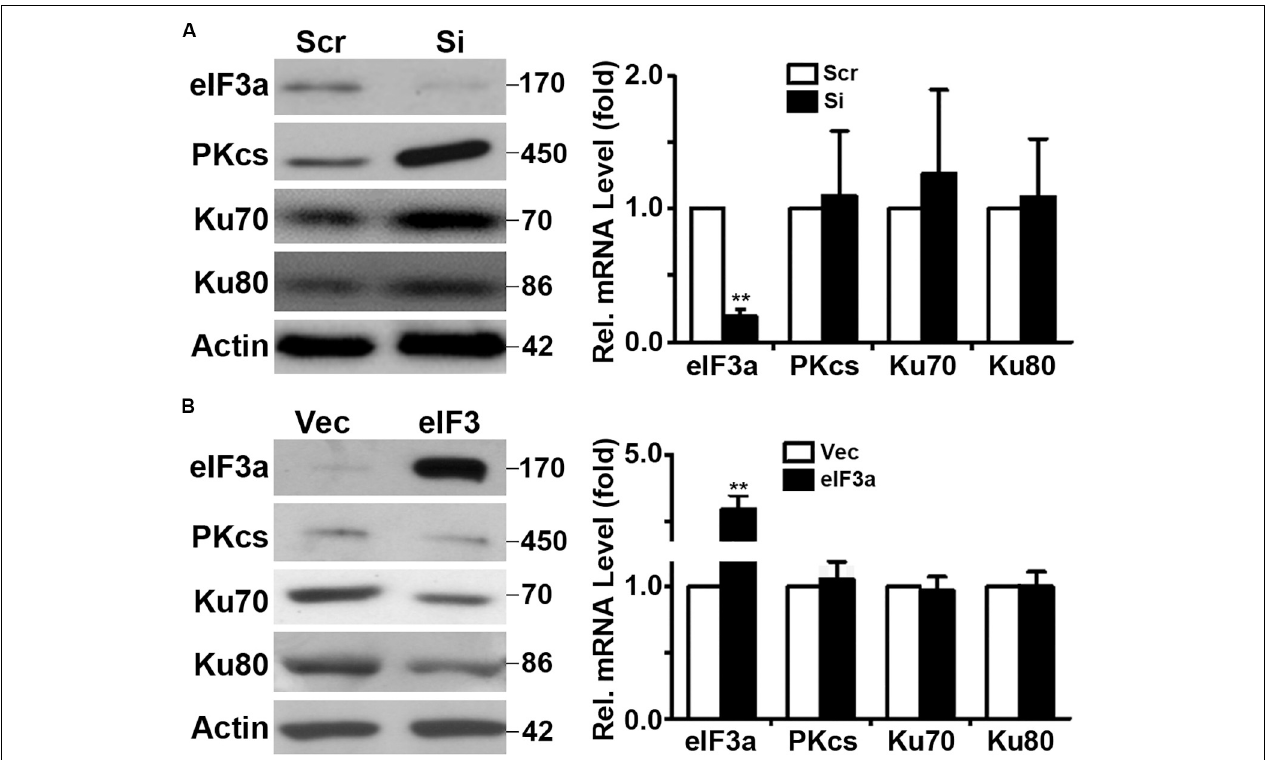
FIGURE 4 | Effect of eukaryotic initiation factor (eIF)3a on expression of genes encoding proteins important for non-homologous end joining (NHEJ) repair. Western blot and real-time reverse transcription (RT)-PCR analyses were performed to determine the effect of eIF3a on the expression of Ku70, Ku80, and DNA-PKcs genes in H1299 cells with transient knockdown (A) and NIH3T3 cells with stable eIF3a overexpression (B) compared with their respective control cells ( n = 3; ** P <